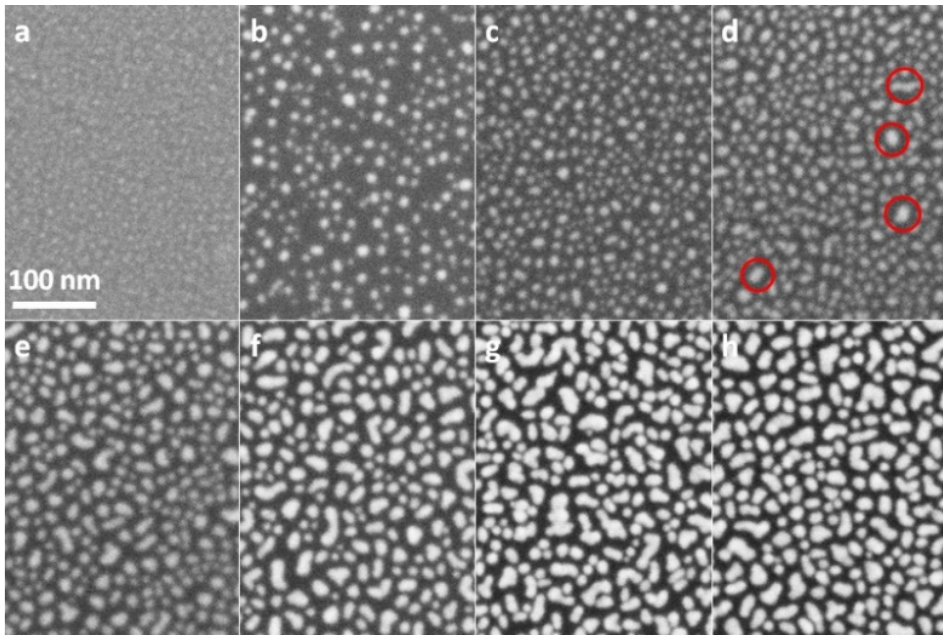
Figure 2. SEM images of Au@Si substrates with sputtering time of 20 s ( a ), 40 s ( b ), 60 s ( c ), 80 s ( d ), 100 s ( e ), 120 s ( f ), 140 s ( g ), and 160 s ( h ).